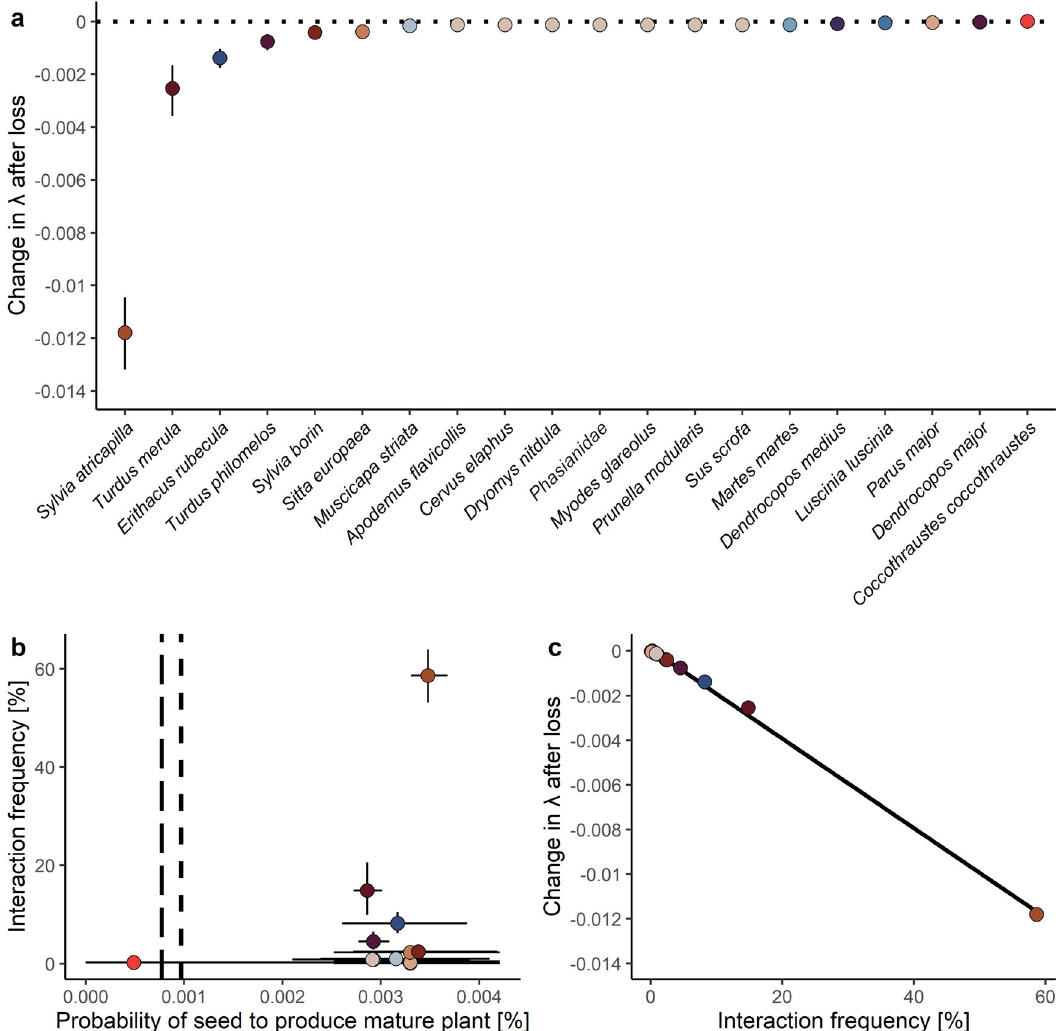
Fig. 3 Total effectiveness of seed dispersal by animals. a Projected consequences of the extinction of each of 20 frugivorous animals on the population growth rate of F. alnus assuming complete interaction de fi cit (i.e., the interactions with an animal are lost completely). Animal species are in order of declining importance as dispersers for F. alnus . Animal species depicted by the same color ( ‘ other ’ frugivores, see Supplementary Table 3) were assigned the same values for seed removal and for seed deposition, resulting in the same estimate for seed dispersal effectiveness. b The ‘ landscape ’ of seed dispersal effectiveness of animal species and gravity dispersal for F. alnus . The y-axis represents the quantity of seed dispersal (i.e., the relative interaction frequency of each animal species with F. alnus ) and the x-axis represents the quality of seed dispersal (i.e., the probability of a seed to produce a mature plant when dispersed by a certain animal species). The two vertical lines depict the consequences of exclusive gravity dispersal in the two scenarios shown in Fig. 2 for seed dispersal quality. c The relationship between seed dispersal effectiveness (i.e., change in population growth after interaction loss) and the relative interaction frequency of different animal species with F. alnus . Color coding in ( b ) and ( c ) is the same as in ( a ) and Fig. 1c. Mean ± 95% prediction intervals based on 500 bootstraps of dispersal